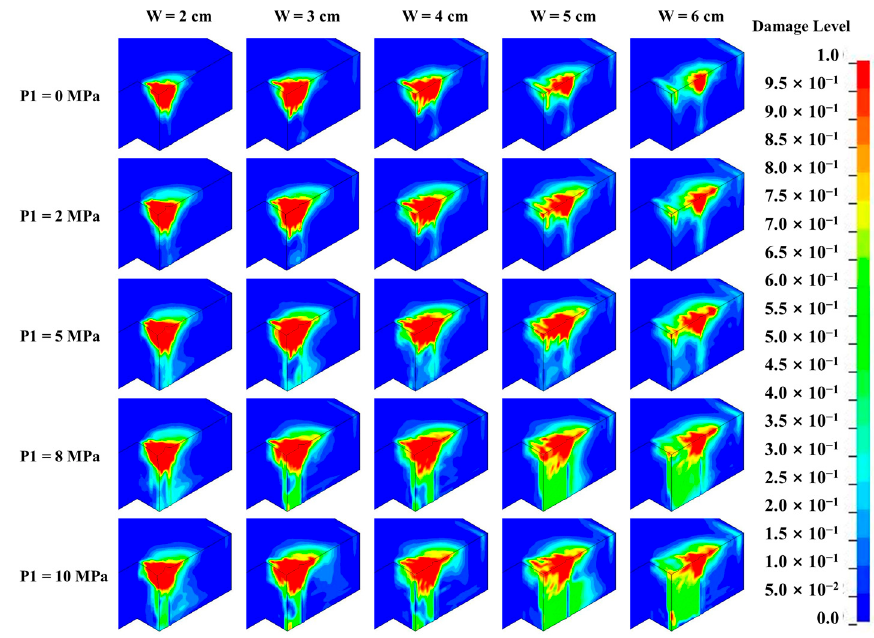
Appl. Sci. 2021 , 11 , x FOR PEER REVIEW Figure 4. Damage contours for each burden under different static loads (P1) at cut Z1.